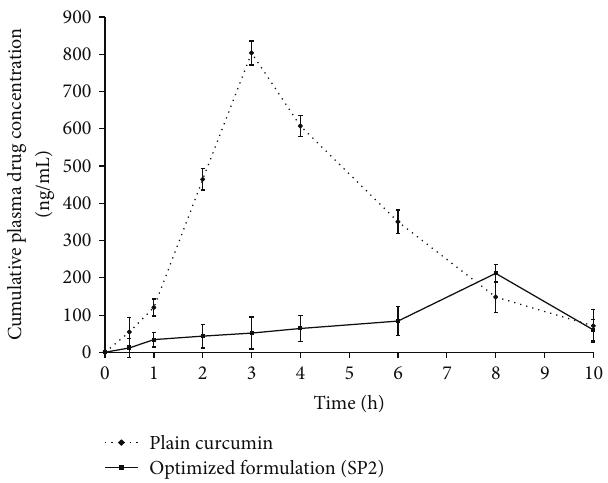
Figure 9: In vivo curcumin release from plain CUR and optimized SNP formulation (SP2) ( 𝑛 = 5